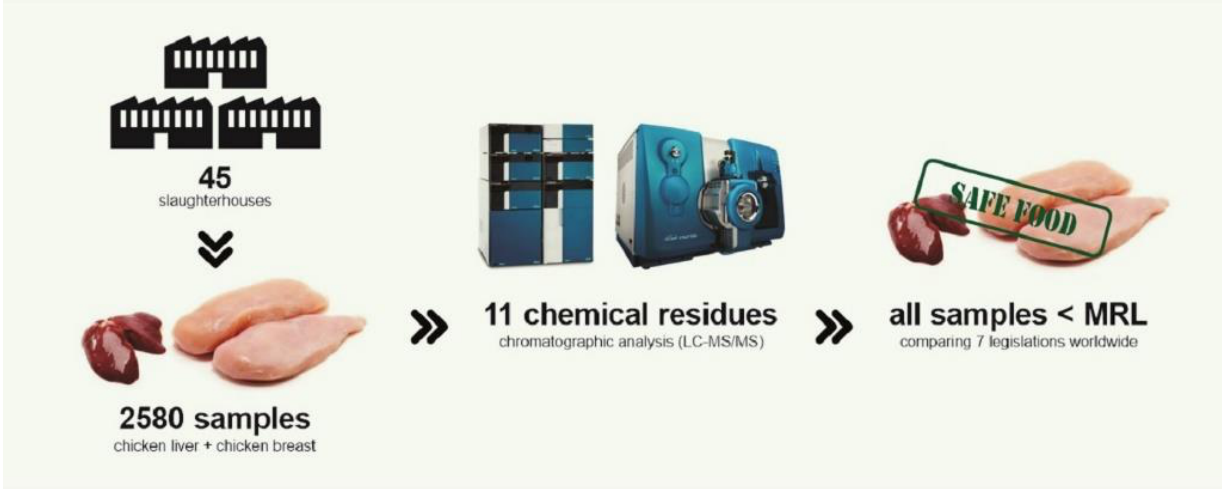
Figure 2. Chicken meat sampling and chemical residues determination by LC-MS/MS. 90